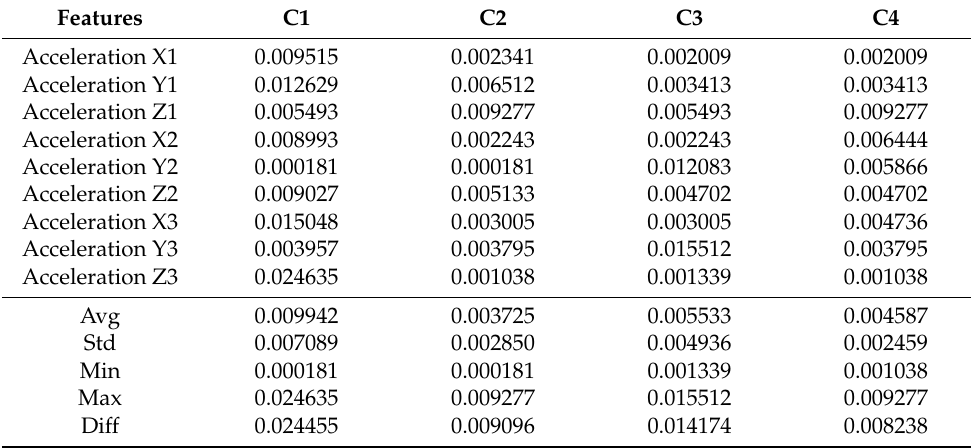
Table 15. Input signals on the operating